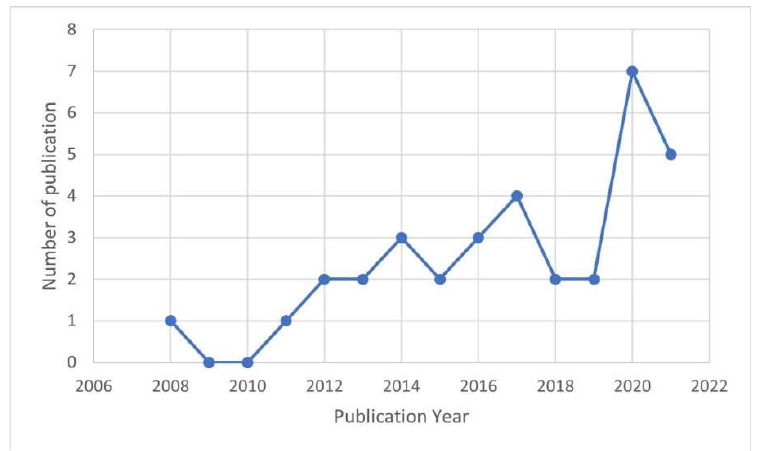
Figure 2. Research trends. Figure 2. Research